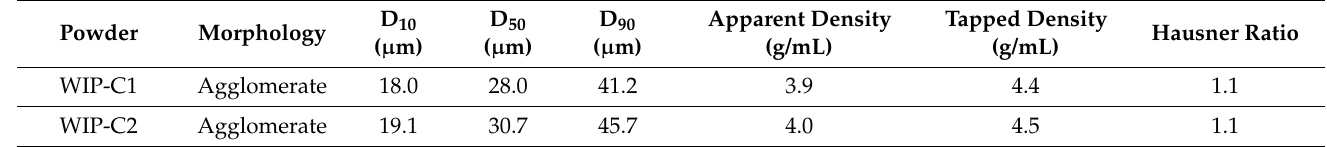
Table 1. General characterization metrics for the WIP powders considered in this study. Powder